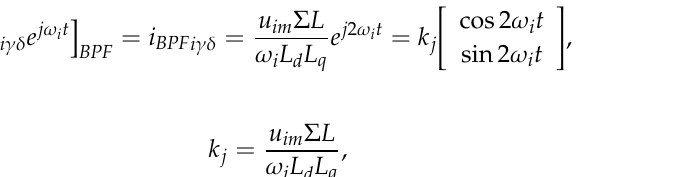
Figure 4. An equivalent block diagram for PMSM speed and position estimation based on sliding mode observer (SMO).